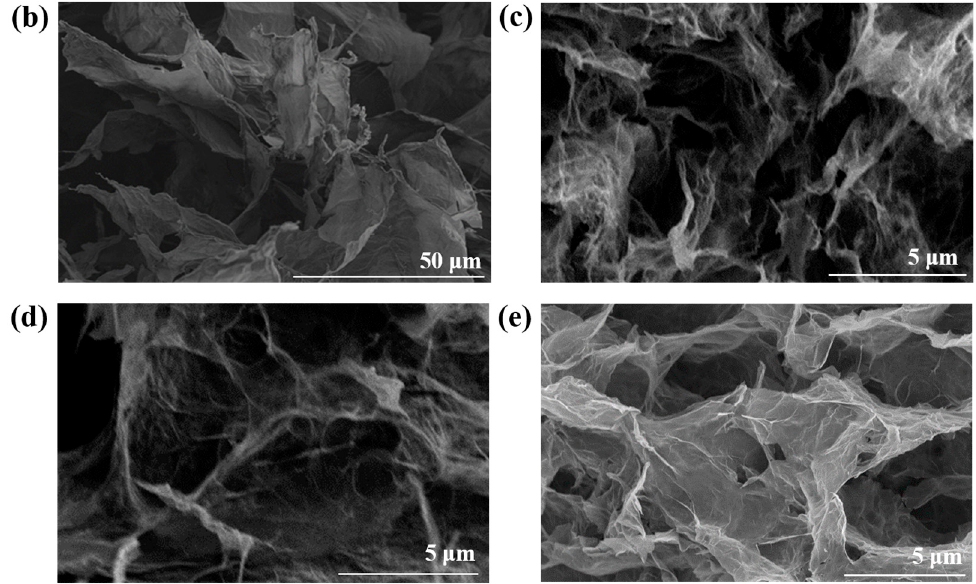
Figure 1. ( a ) Illustration of preparing CDs@r-GO composite materials; Scanning electron microscope images of ( b ) GO, ( c ) CDs@r-GO-1, ( d ) CDs@r-GO-4 and ( e ) CDs@r-GO-6.